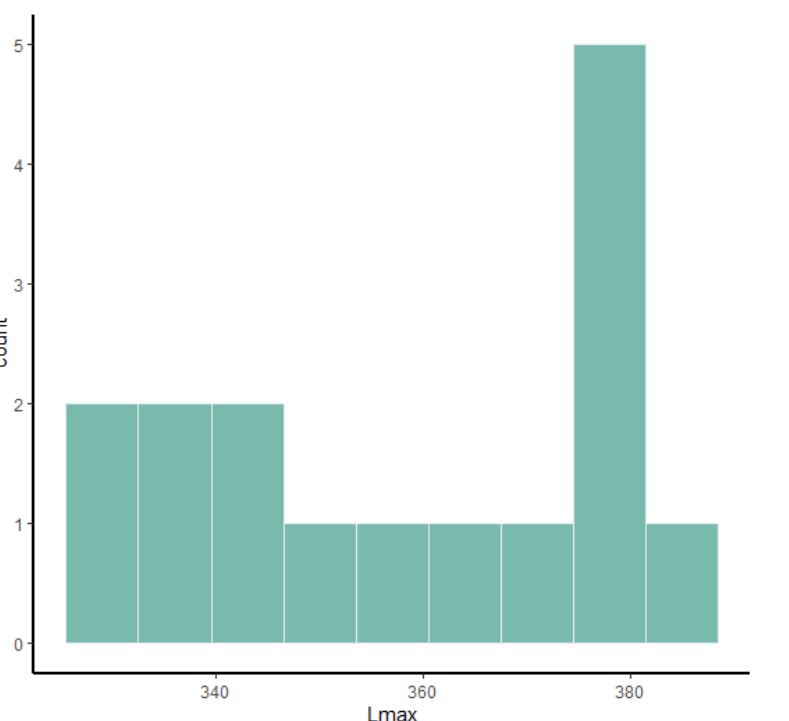
Figure 1. ( a ) Frequency distribution of the maximum length (Lmax) and ( b ) the anterior – posterior diameter of the shaft in the radius of S. etruscus.